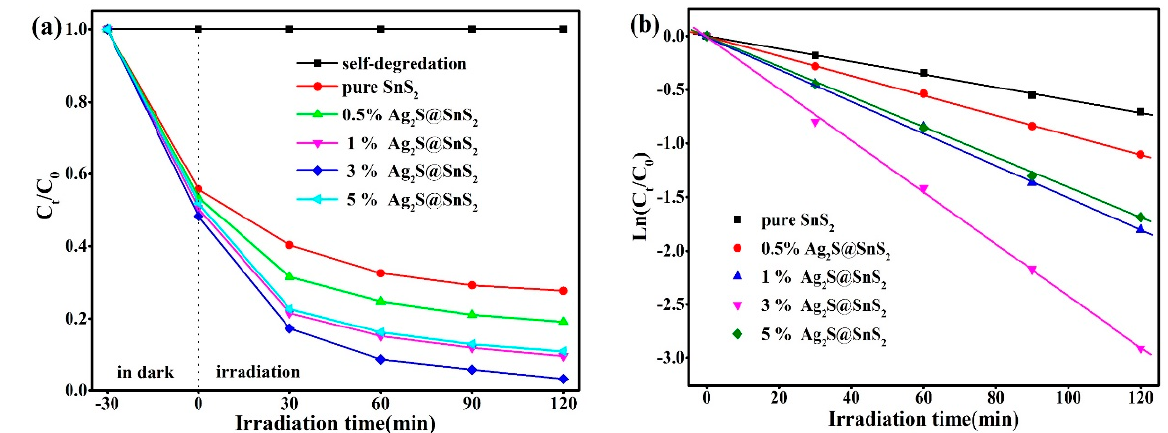
Figure 7. The photocatalytic degradation of RhB over time ( a ); the first-order kinetic curve ( b ) for pure SnS 2 and Ag 2 S@SnS 2 composites.